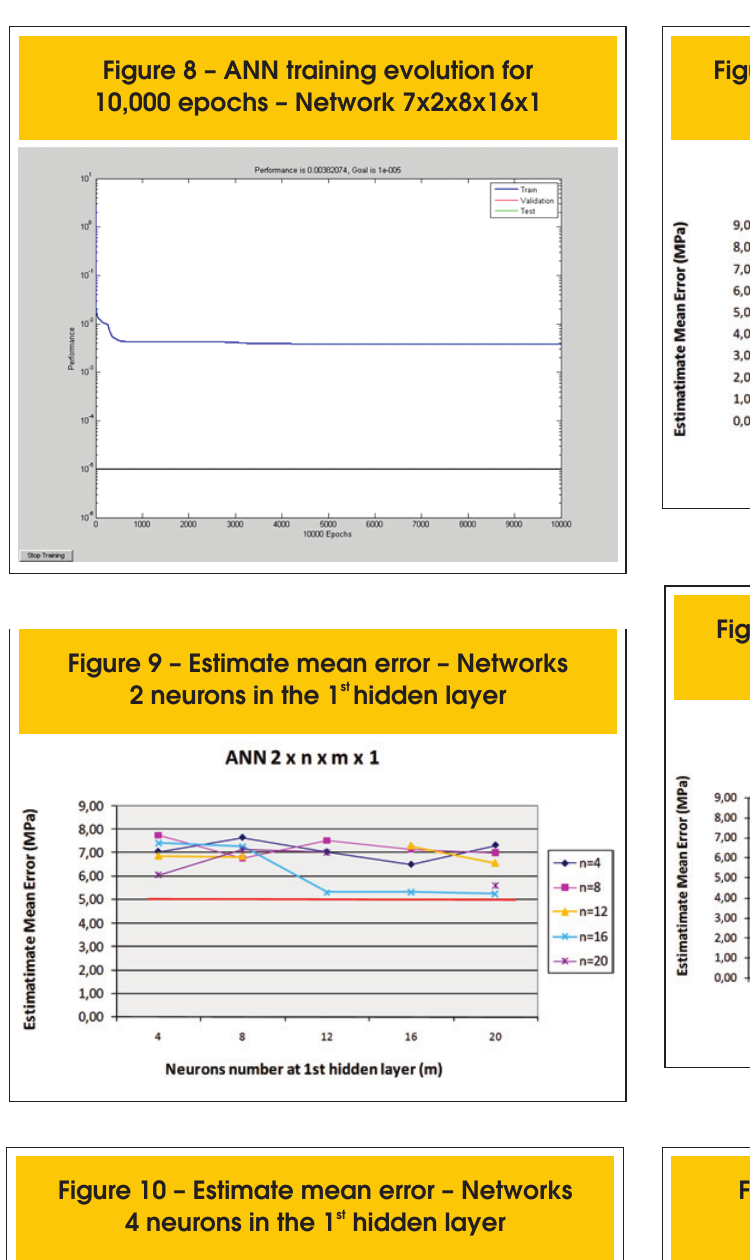
Figure 13 – Mean error ranges (in MPa) of the performed